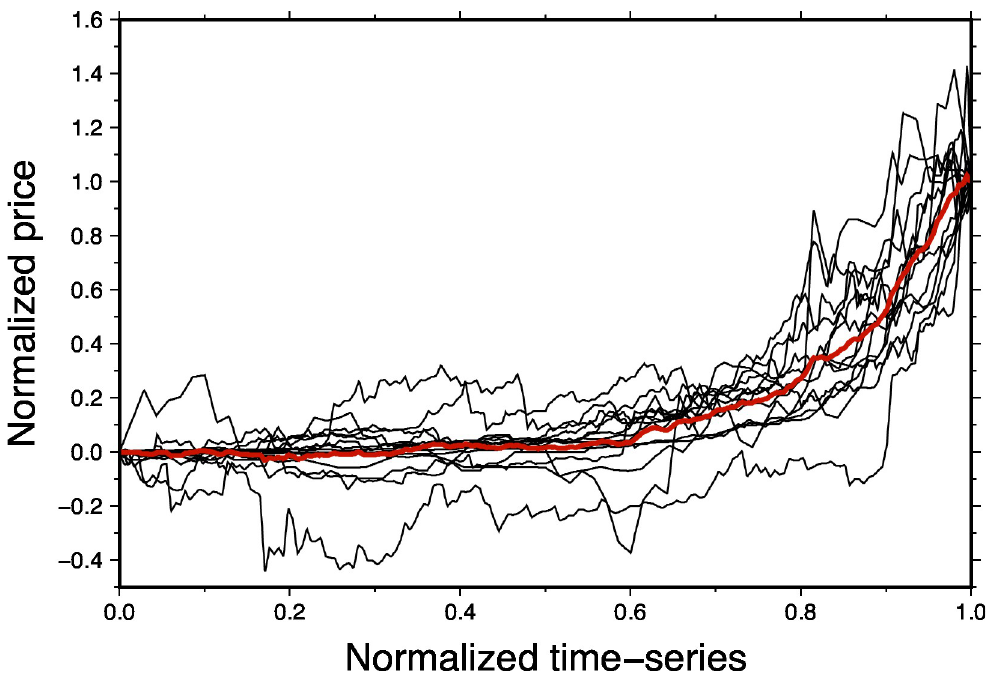
Fig 4. Time- and Price- normalized data segment preceding price peaks. Average price history is plotted using a red line. From a price of less than USD1 to > USD 55k, events shows self-similarity. All prices increases are contained within a time- frame of 50–70 days (normalized time ~